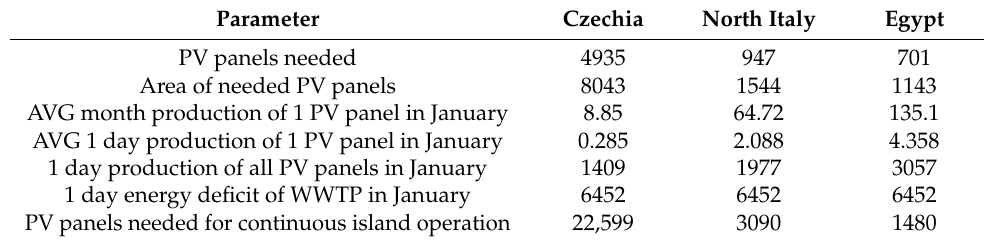
Table 5. Comparison of results for three selected